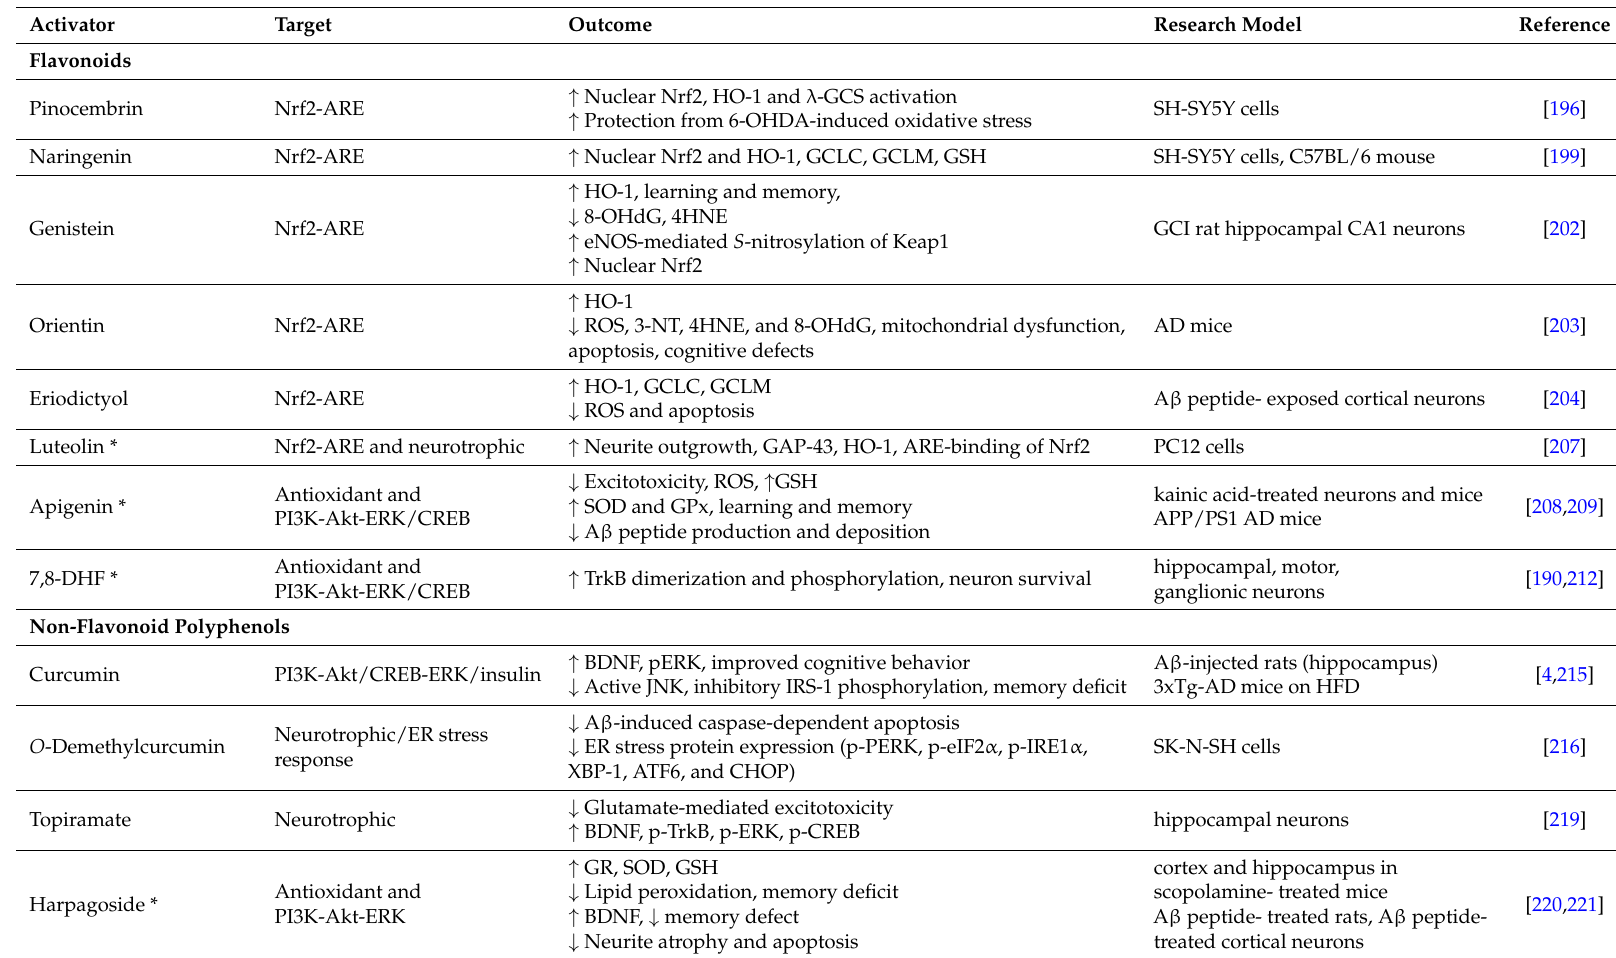
Table 2. Natural compounds that activate Nrf2-ARE and/or neurotrophic PI3K-Akt signaling